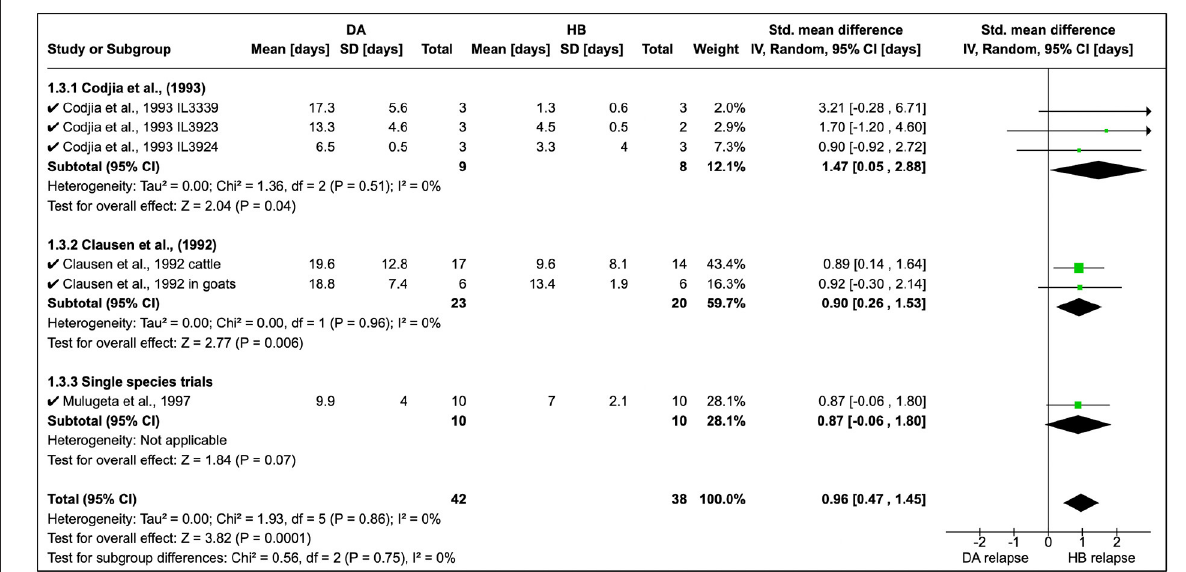
FIGURE4 Mean relapse time in preclinical trials with diminazene aceturate and homidium bromide.